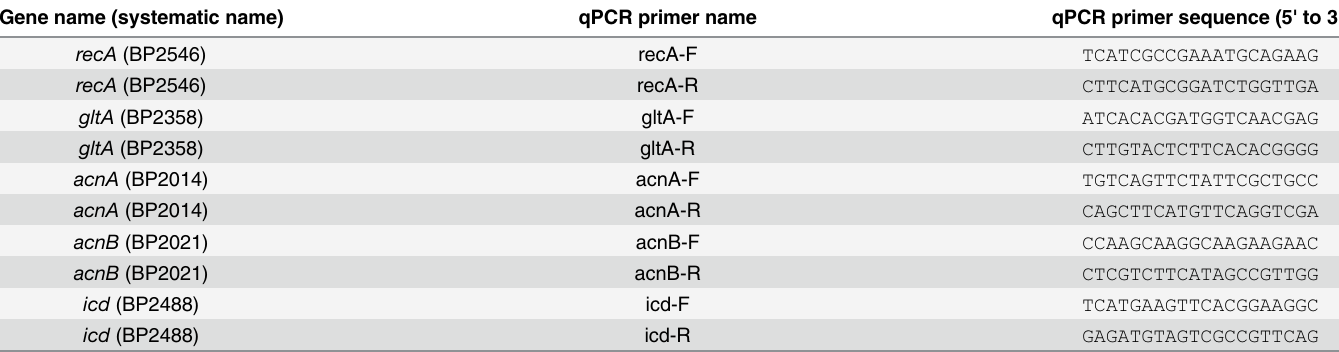
Table 1. Primer pairs for qPCR analysis (F: foward primer; R: reverse primer). Gene name (systematic